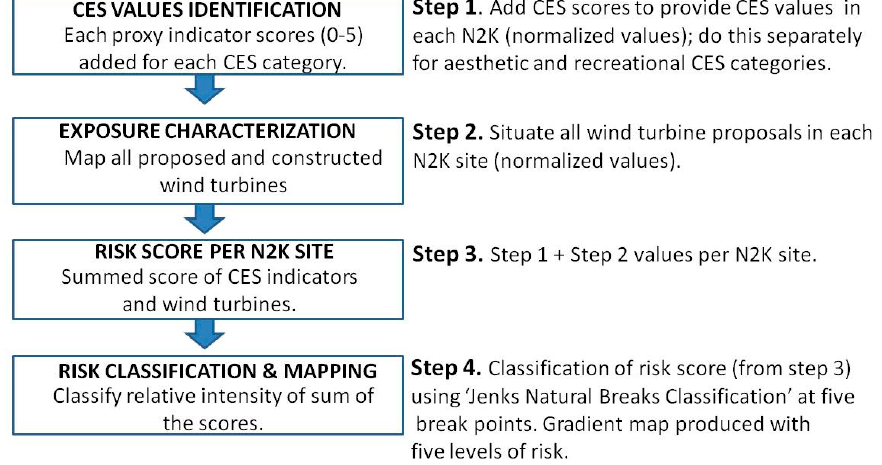
Figure 2. Process of risk classification for wind turbine density per Natura site in relation to CES categories.